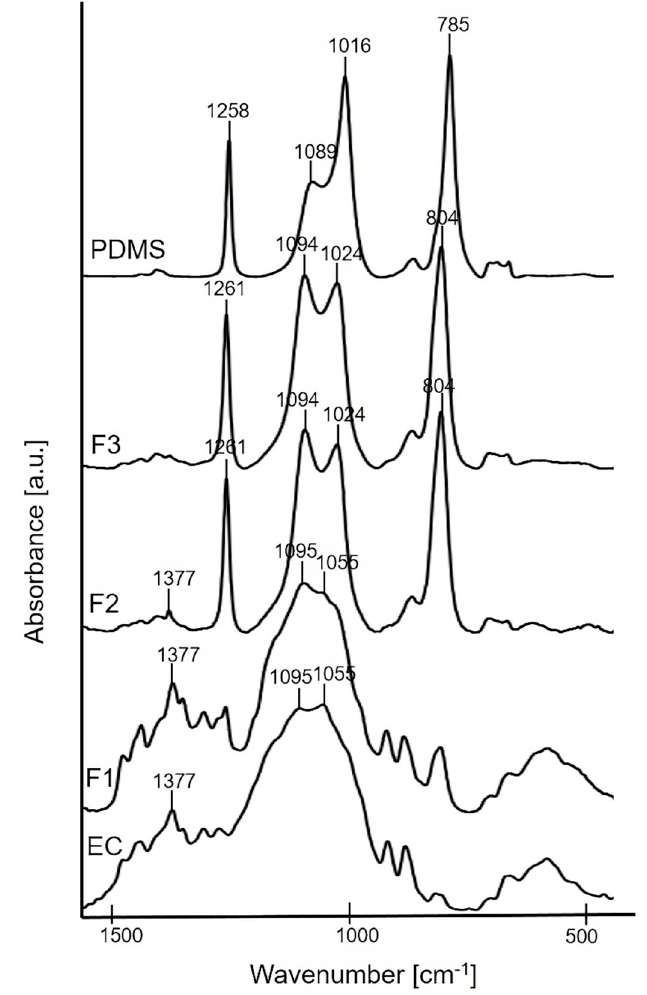
Figure 1. FTIR spectra of F1, F2, F3 solid films, and precursors: EC and PDMS.